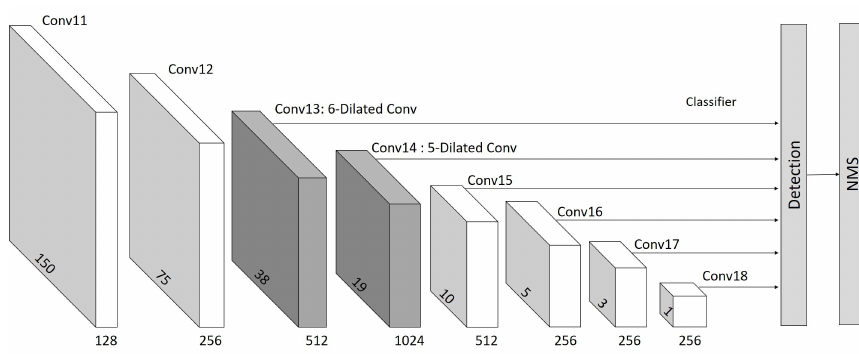
Figure 1. The proposed architecture of U-SSD.